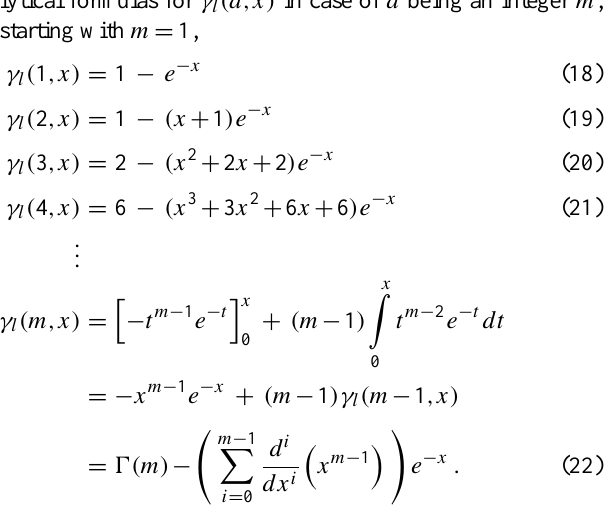
Fig. 4. Relative (left) and absolute (right) error of the proposed approximation ˆ P(a,x) = ˆ γ ( a,x)/0(a) as function of a and x/(a + 1 ) . The parameter x has been scaled by a + 1 because the main variation of P(a,x) with x takes place at x -values around a + 1. The vertical grey lines at a = 0 . 9 indicate the lower boundary with respect to a of the (a,x) -range where errors are acceptable.